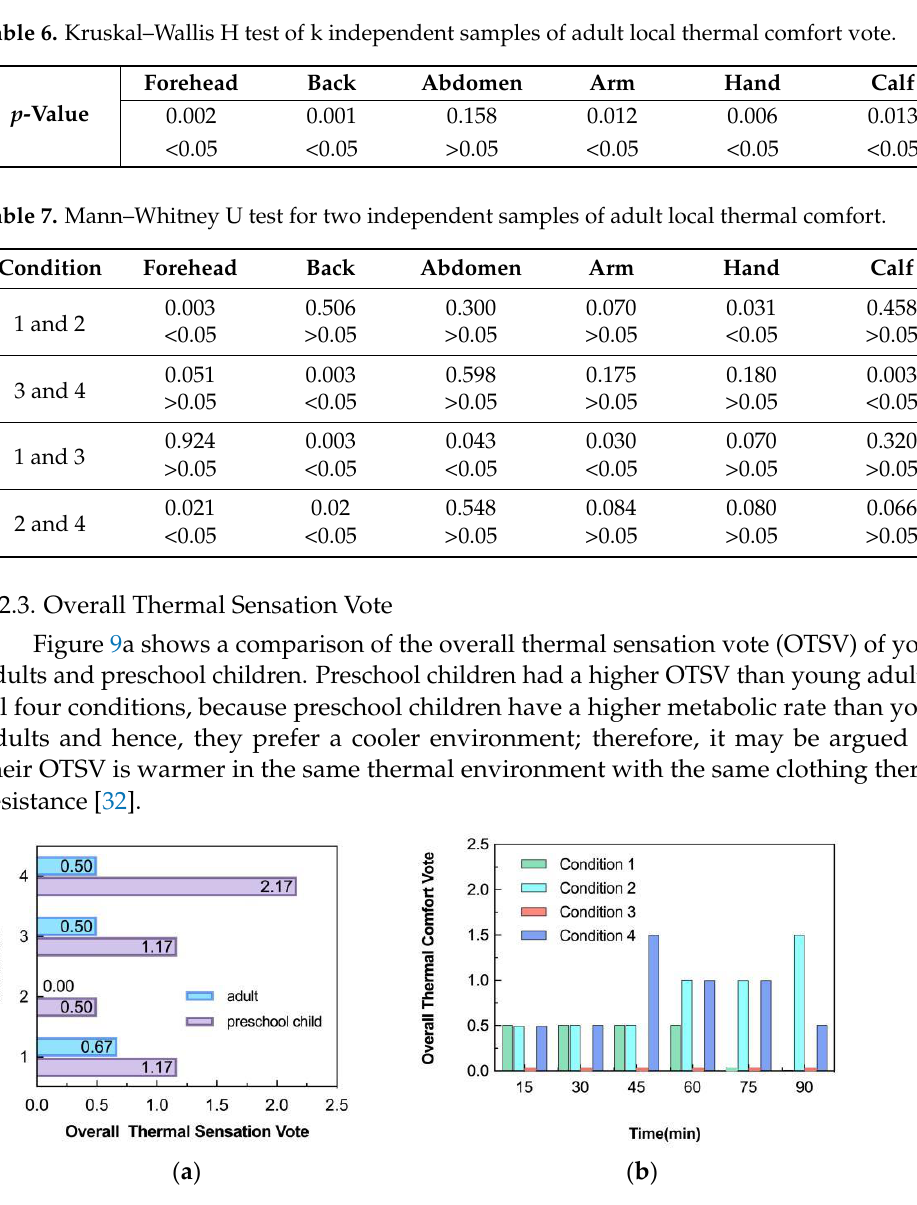
Table 8. Mann – Whitney U test for the overall thermal sensation vote and overall thermal comfort vote of preschool children and young adults. Condition